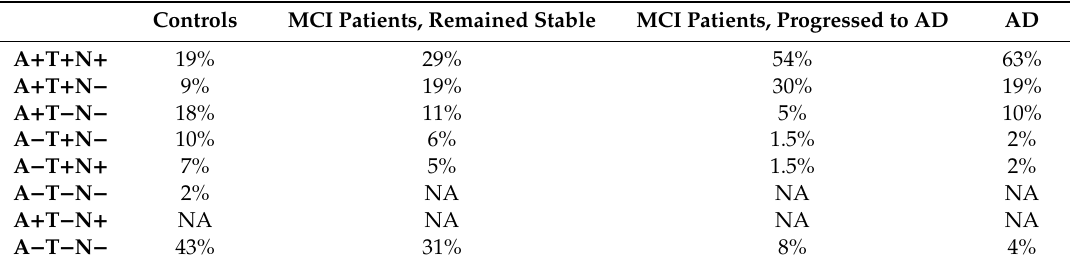
Table 1. A / T / N markers and patterns of brain atrophy in mild cognitive impairment, compared with normal controls and AD patients. Individuals, who were positive for A, T and N markers may have elevated risk for both cognitive decline and MCI to AD